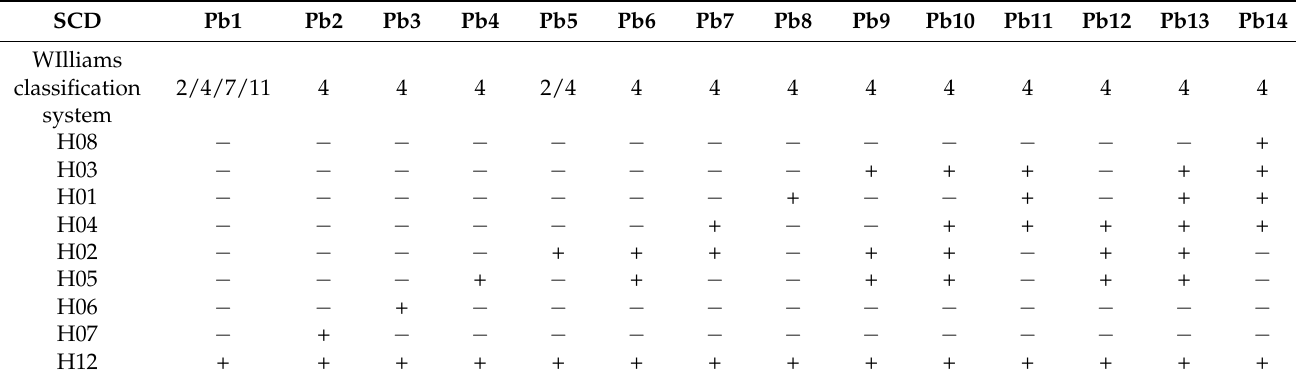
Table 3. The Sinitic clubroot differential (SCD) system